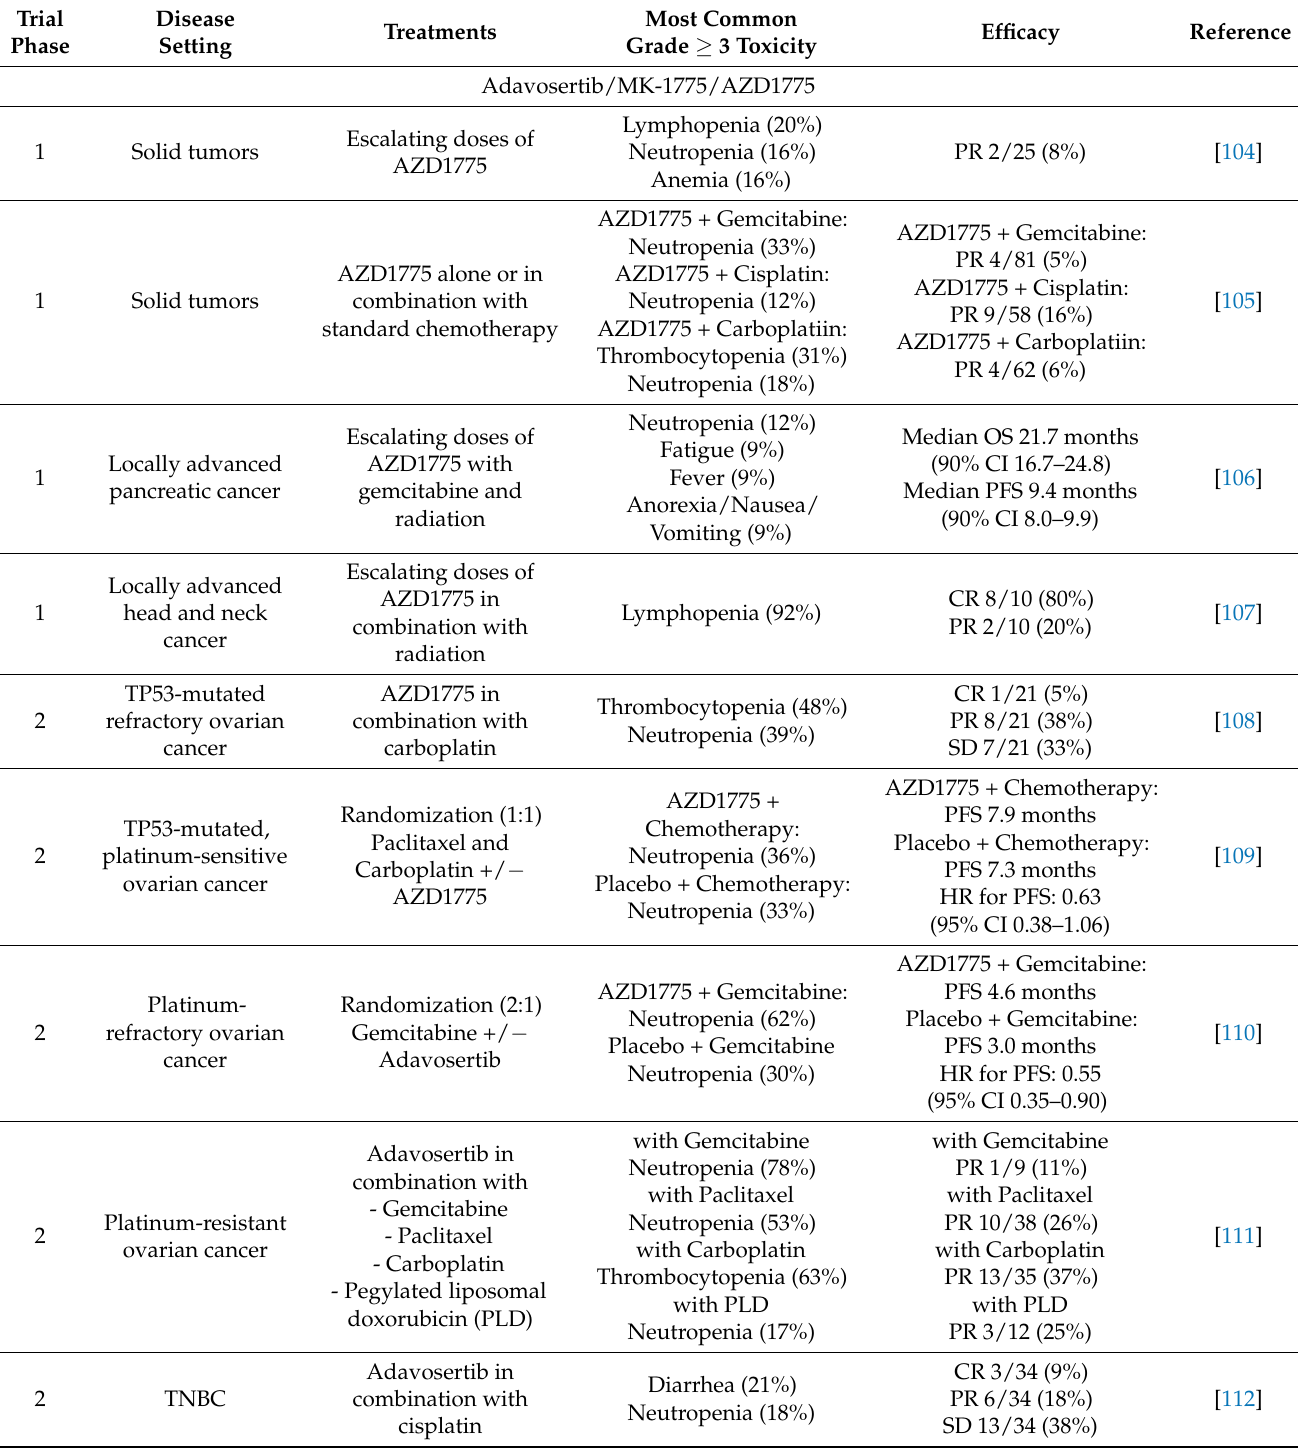
Table 4. Clinical trials of WEE1